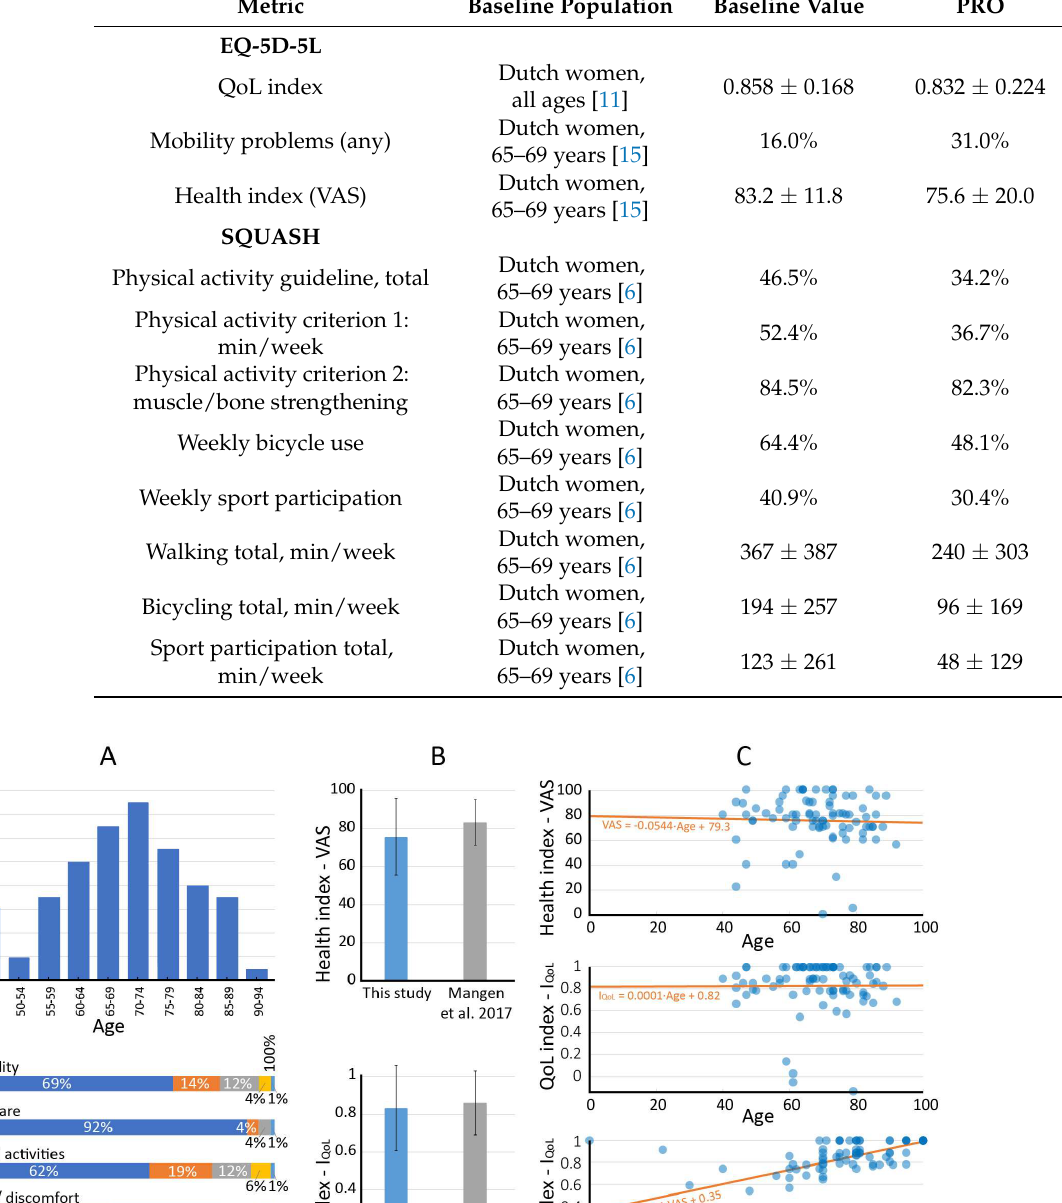
Table 2. Overview of Dutch baseline values and patient-reported outcomes (PRO) of the validated questionnaires in this study.